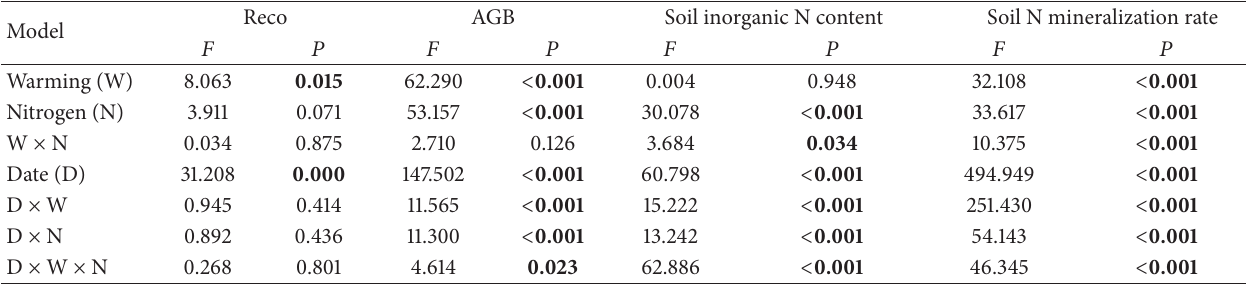
Table 1: Repeated-measure analyses of variance (ANOVAs) for ecosystem respiration (Reco), aboveground biomass (AGB), soil inorganic N content, and mineralization rate in 2012. 𝐹 and 𝑃 values represent 𝐹 value of ANOVA results and statistical significance, respectively. The significant level is 𝑃 < 0.05